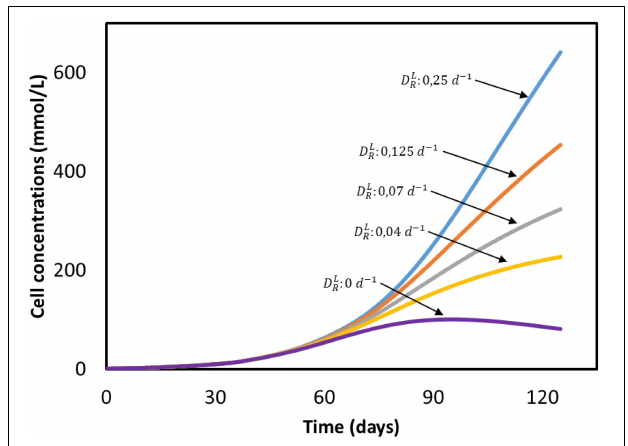
FIGURE 6 | Cell concentrations in time at different dilution rates ( D L R ) based on the system from Marshall et al. (2013). All input parameters are the same between simulations, with the exception of the dilution rate. No experimental data